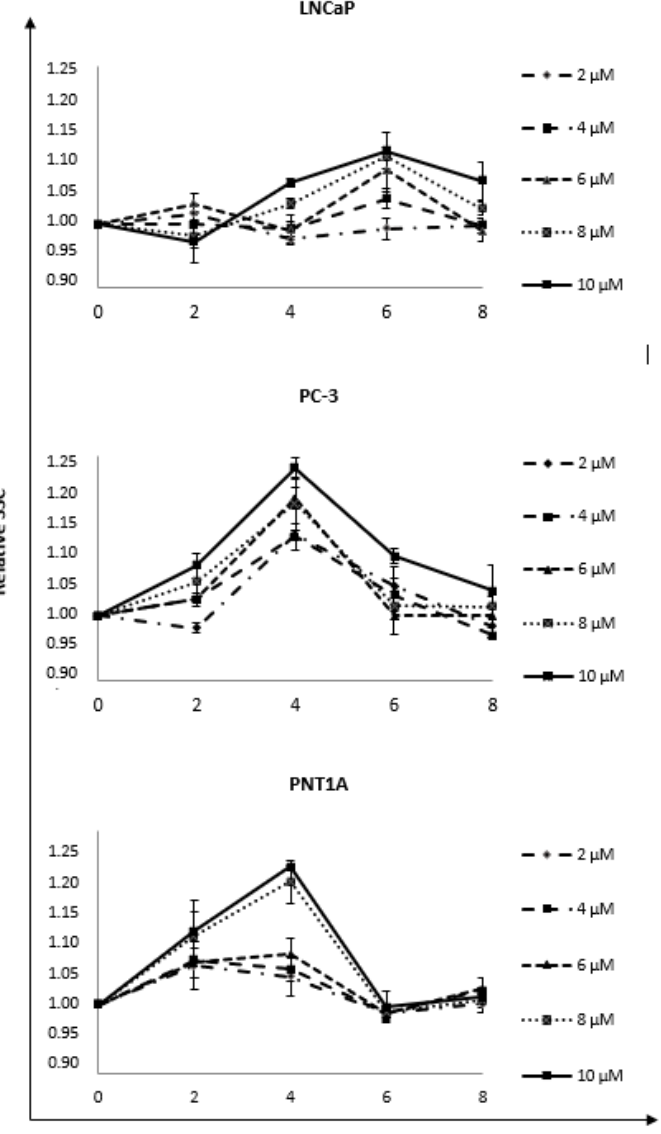
Figure 3. The dynamic of gold nanorods uptake by LNCaP, PC-3, and PNT1A cells. The analysis was performed at four time points 2, 4, 6, and 8 h for five concentrations of nanorods: 2, 4, 6, 8, and 10 µ M. The values presented in the graph are the mean of the obtained results, and the deviation is the standard deviation. The experiment was performed in triplicate.